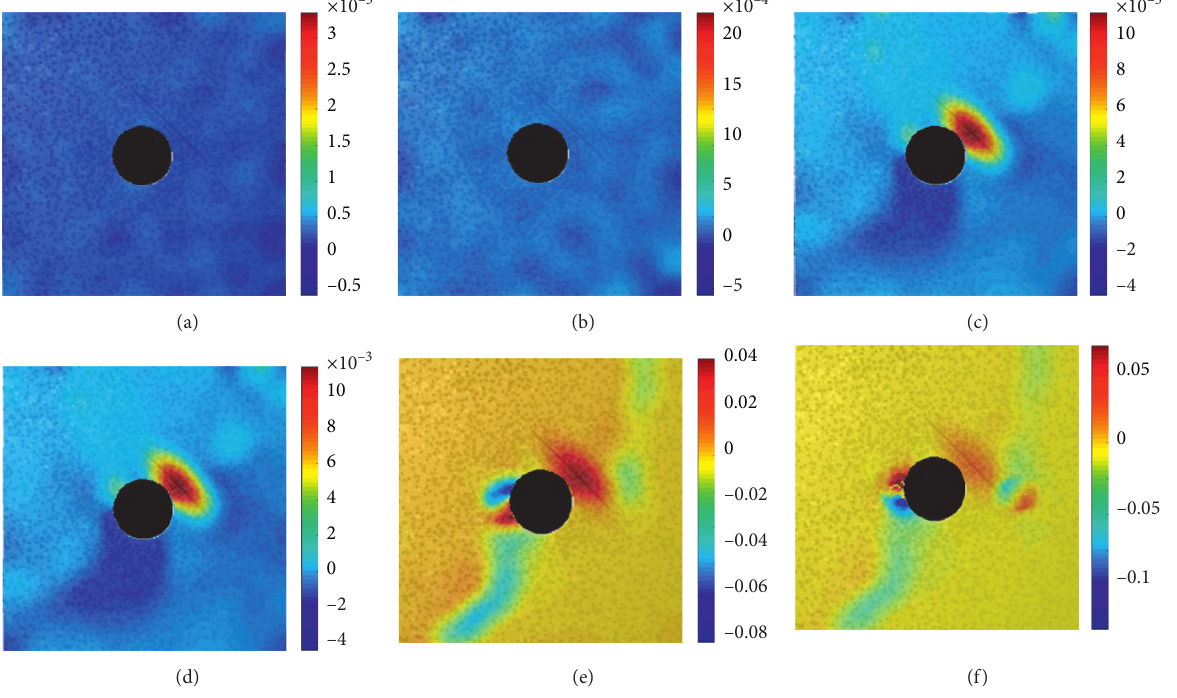
Figure 6: The shear strain contours of model sample A at different test stages: (a) 83sec. (b) 87sec. (c) 299sec. (d) 305sec. (e) 307 sec. (f)